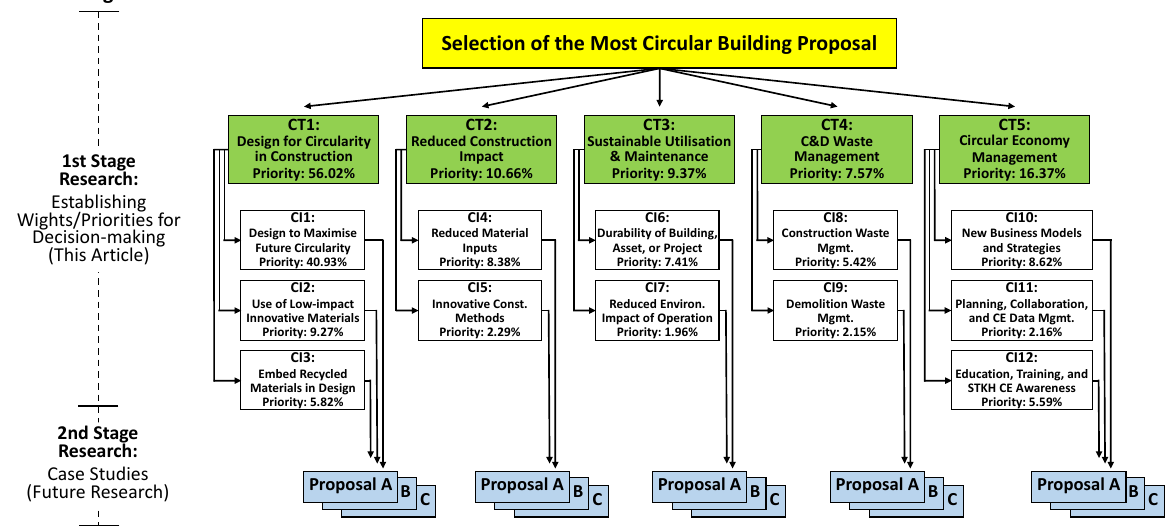
Selection of the Most Circular Building Proposal